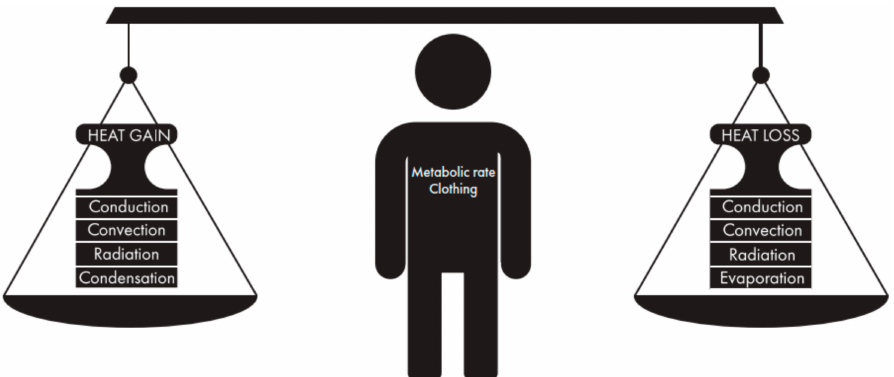
Figure 1. Human body heat balance is calculated by metabolic rate and the heat exchange by radiation, convection, evaporation, and conduction. The heat balance is the result of the positive fluxes and negative fluxes and will be influenced by individual factors and clothing